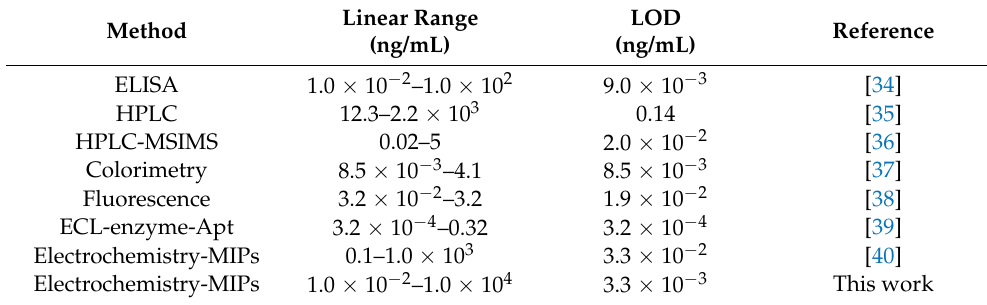
Table 1. Comparative study of this work with previously reported sensors for the detection of CAP.